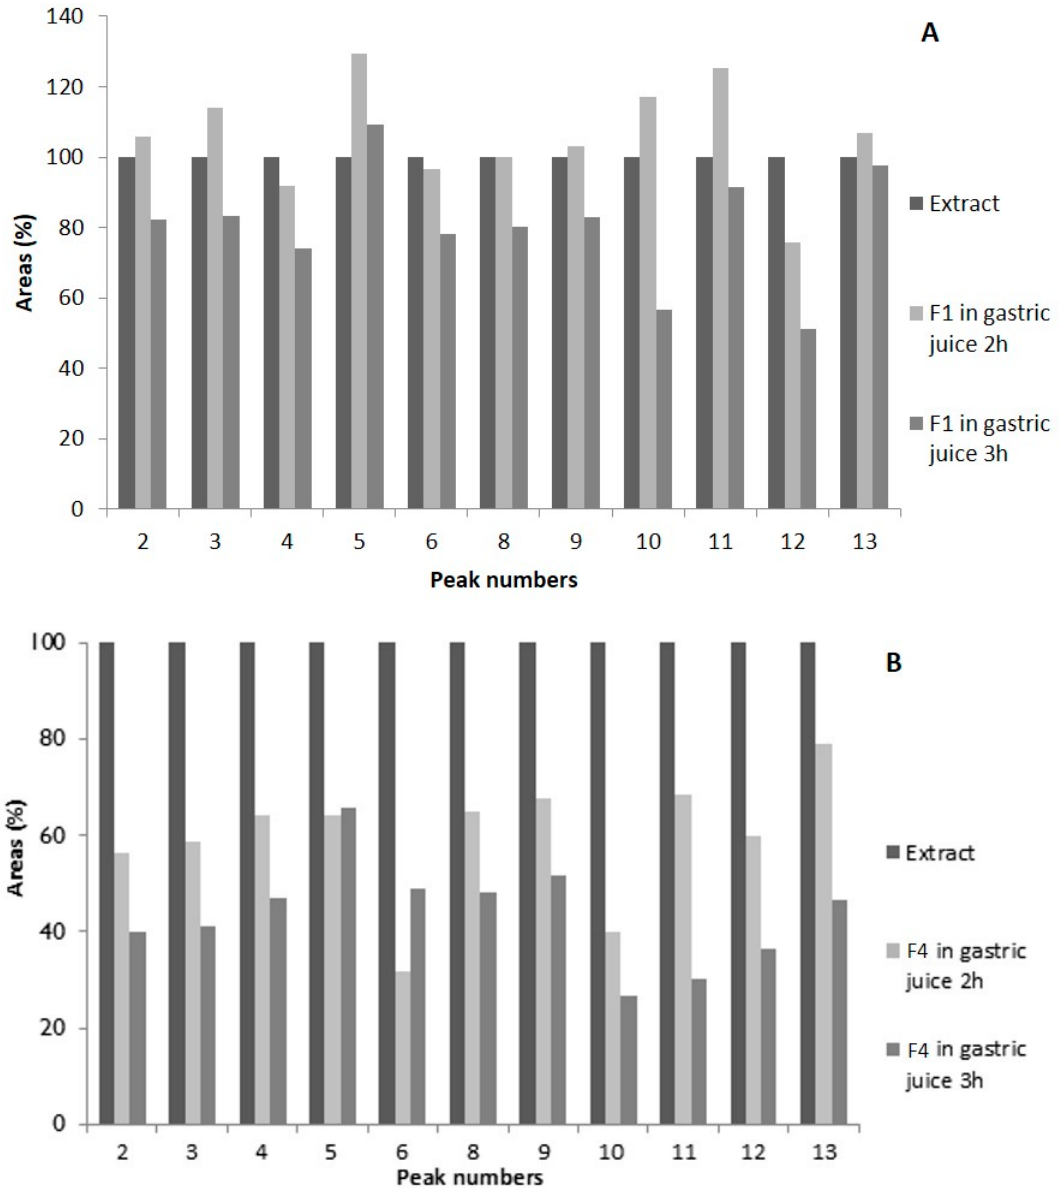
Figure 5. Representation of the area variation (at 320 nm), in per cent, of the peaks obtained (2–13) by HPLC-PDA for the F1 and F4 formulations in relation to the extract not subjected to gastric juice. F1—Extract and corn starch ( A ); F4—extract ( B ). Average values calculated from n = 2. Identification of peaks in Table 1.